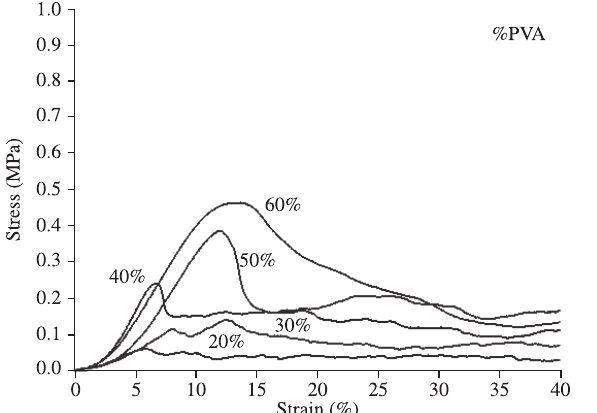
Figure 6. Compression stress-strain curves of hybrid foams with 20 to 60 wt. (%) PVA before neutralization.